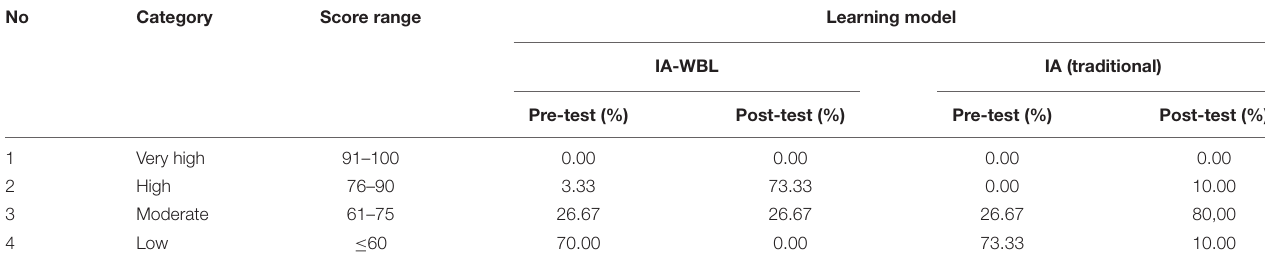
TABLE 3 | The results of the pre-test and post-test knowledge on industrial apprenticeship.